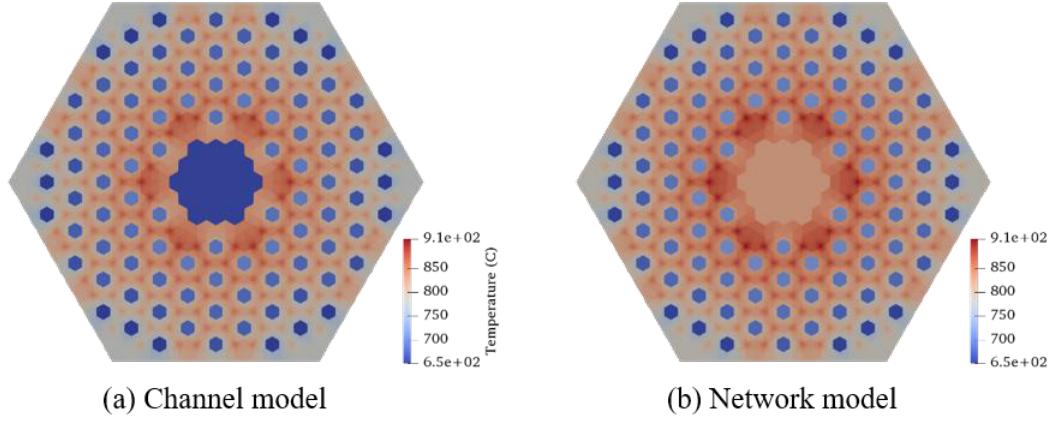
Figure 6. Radial Temperature Distribution at the Bottom of Active Region for Single Column